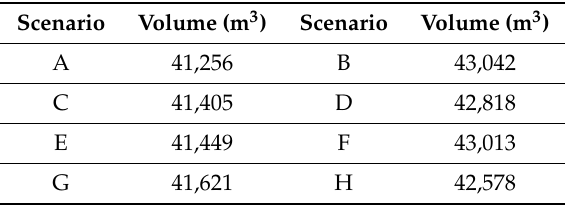
Table 2. Volume computed in each UAV flight scenario.